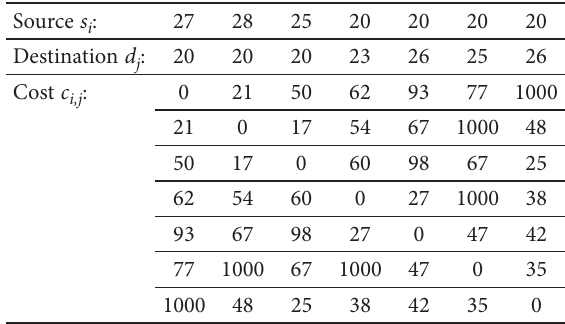
Table 1. 7×7 cost matrix and source/destination